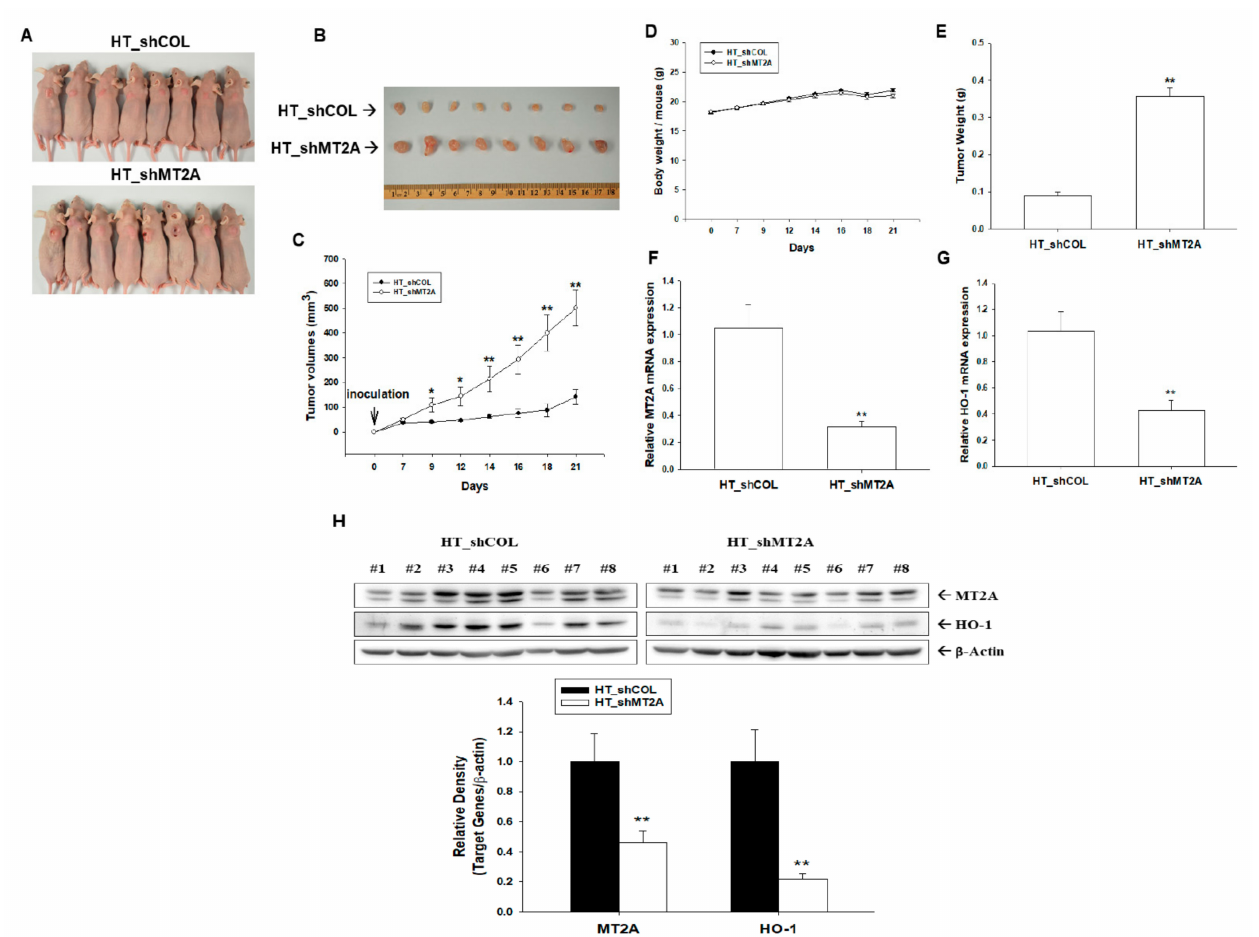
Figure 7. Modulating effect of MT2A on tumor growth of bladder carcinoma HT1376 cells. Four- week-old male athymic nude mice were divided randomly into two groups. ( A ) HT_shCOL and HT_shMT2A cells (6 × 10 6 ) were injected subcutaneously in the dorsal area of the mice ( n = 8). ( B ) Tumors from HT_shCOL and HT_shMT2A cells were recorded after mice were sacrificed. The volumes of tumor ( C ) and body weight ( D ) were measured every 2–3 days during a period of 21 days. The ( E ) tumor weight ( ± SE; n = 8), mRNA levels ( ± SE; n = 8) of MT2A ( F ) and HO-1 ( G ), and ( H ) protein levels of MT2A and HO-1 ( ± SE; n = 8) of the tumors from HT_shCOL and HT_shMT2A cells were recorded after mice were sacrificed. * p < 0.05; ** p <